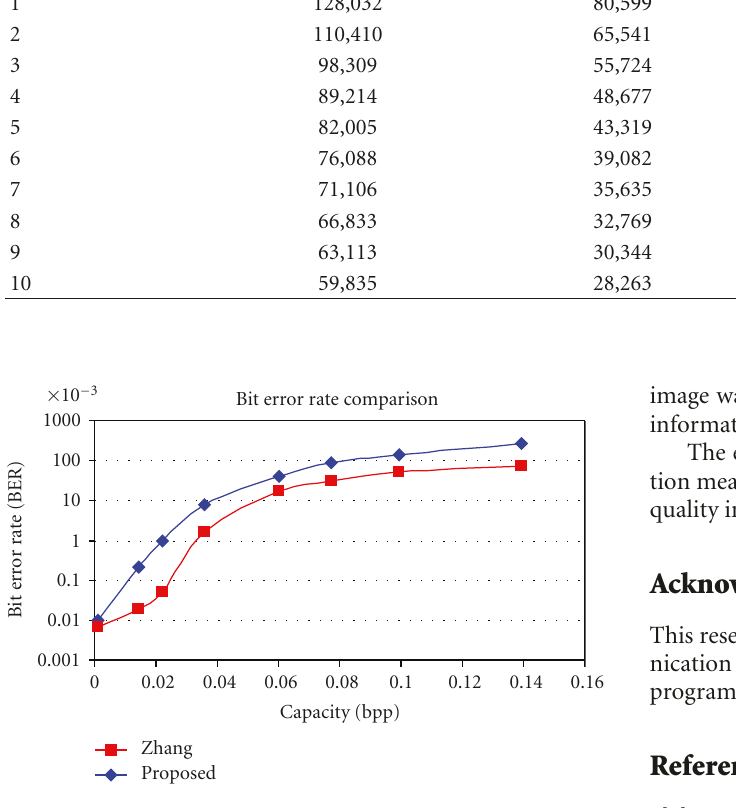
Figure 11: Comparison of Bit Error Rate via Capacity (in